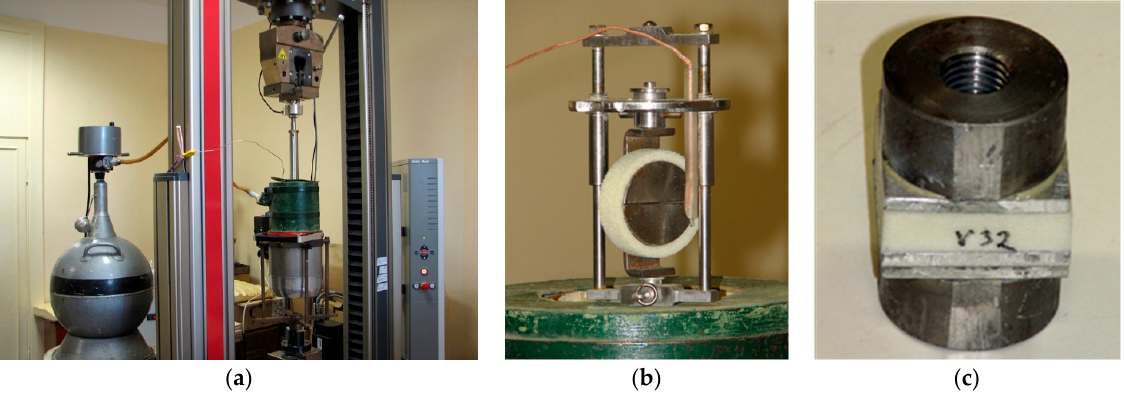
Figure 1. ( a ) Testing machine Zwick/Roell Z100 with a cryogenic test facility. ( b ) Appliance for ring tensile test at cryogenic temperature. ( c ) PUR sample for bond strength determination